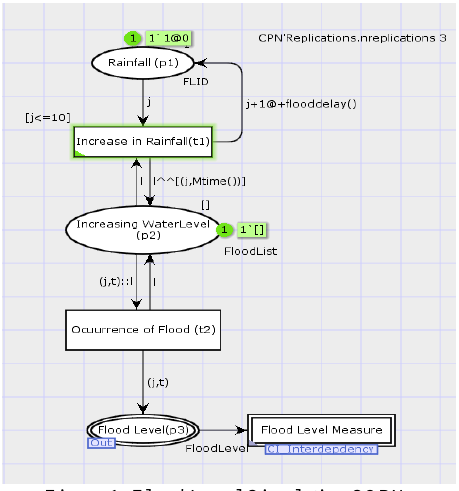
Figure 1. Flood Level Simulation SCPN.